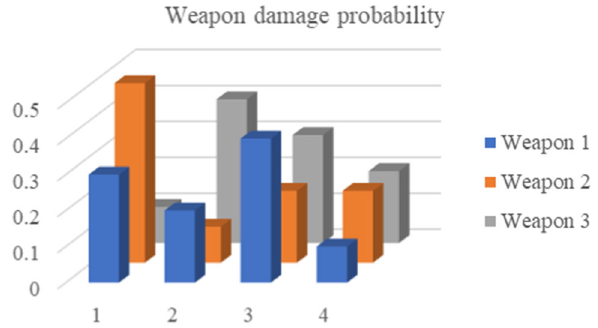
Fig. 3 The histogram of the weapon damage probability for case